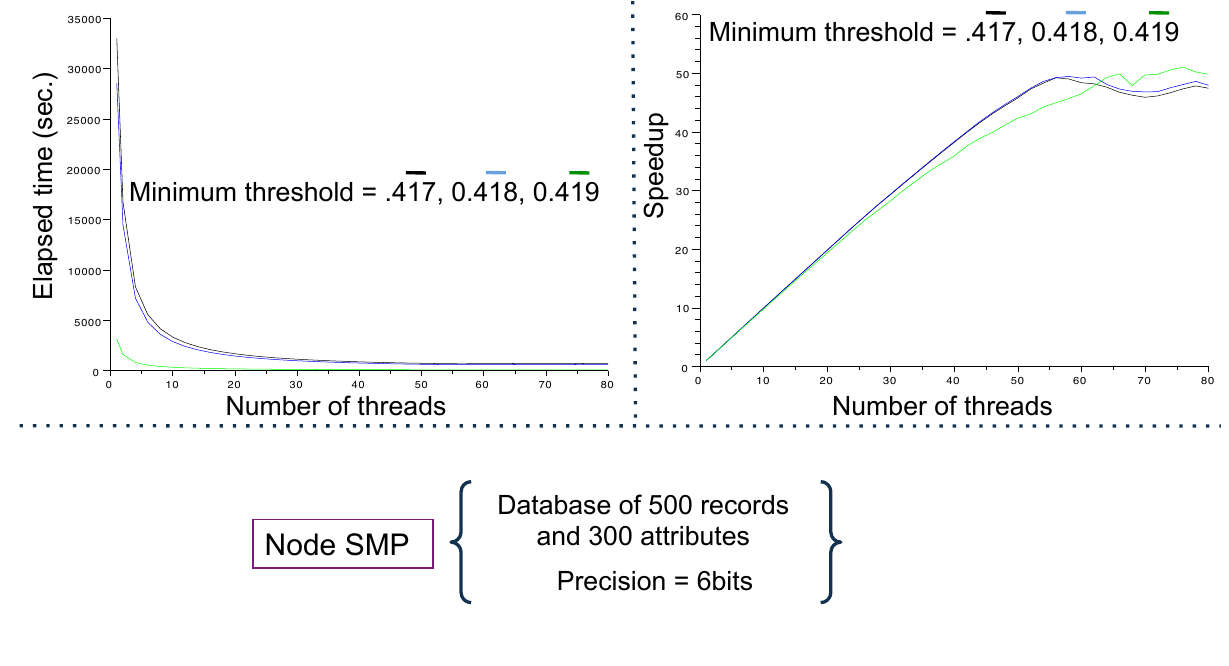
Figure 9. Execution time and Speedup related to the number of threads on SMP nodes for synthetic database of 300 attributes at precision 6 bits with minimum threshold values 0.4181 and